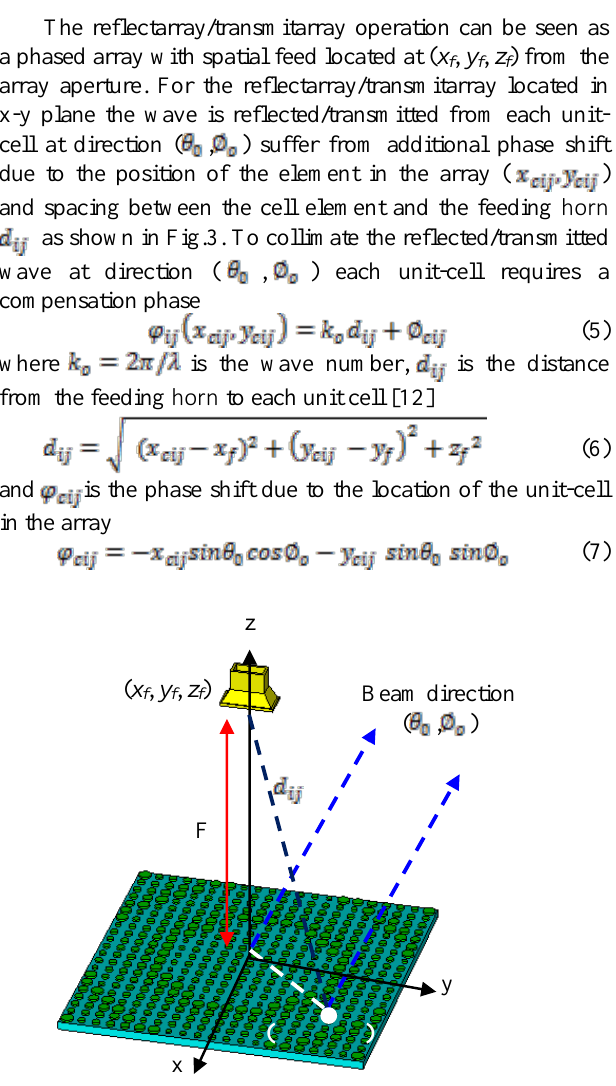
Figure 3 The detailed structure of the reflectarray/ transmitarray